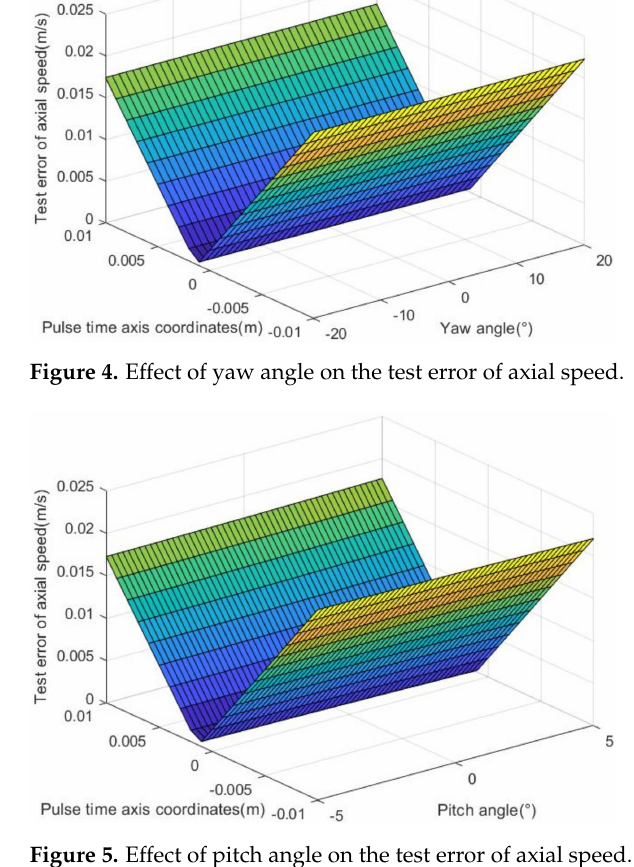
Figure 5. Effect of pitch angle on the test error of axial